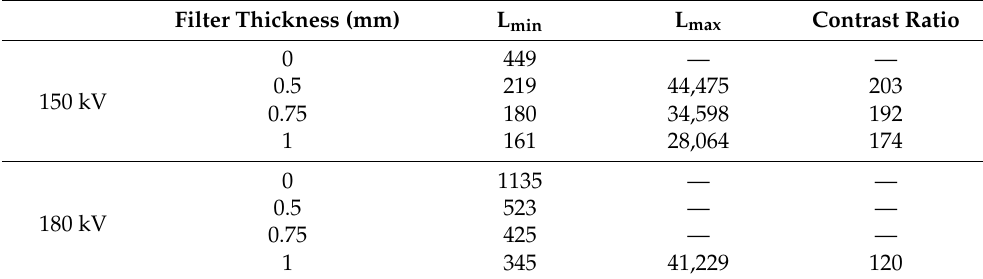
Table 1. Image contrast of Fe (20 mm thick) and Al (1 mm thick).